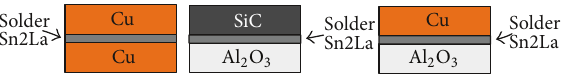
Figure 1: Analysed combinations of Cu/Cu, SiC/Al 2 O 3 , and Cu/ Al 2 O 3